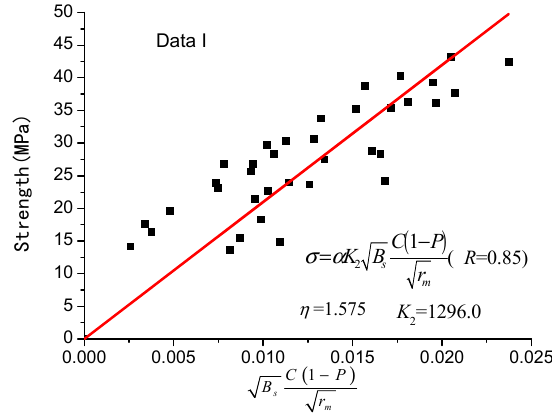
Figure 2. Equation (8) revised strength model (data I).